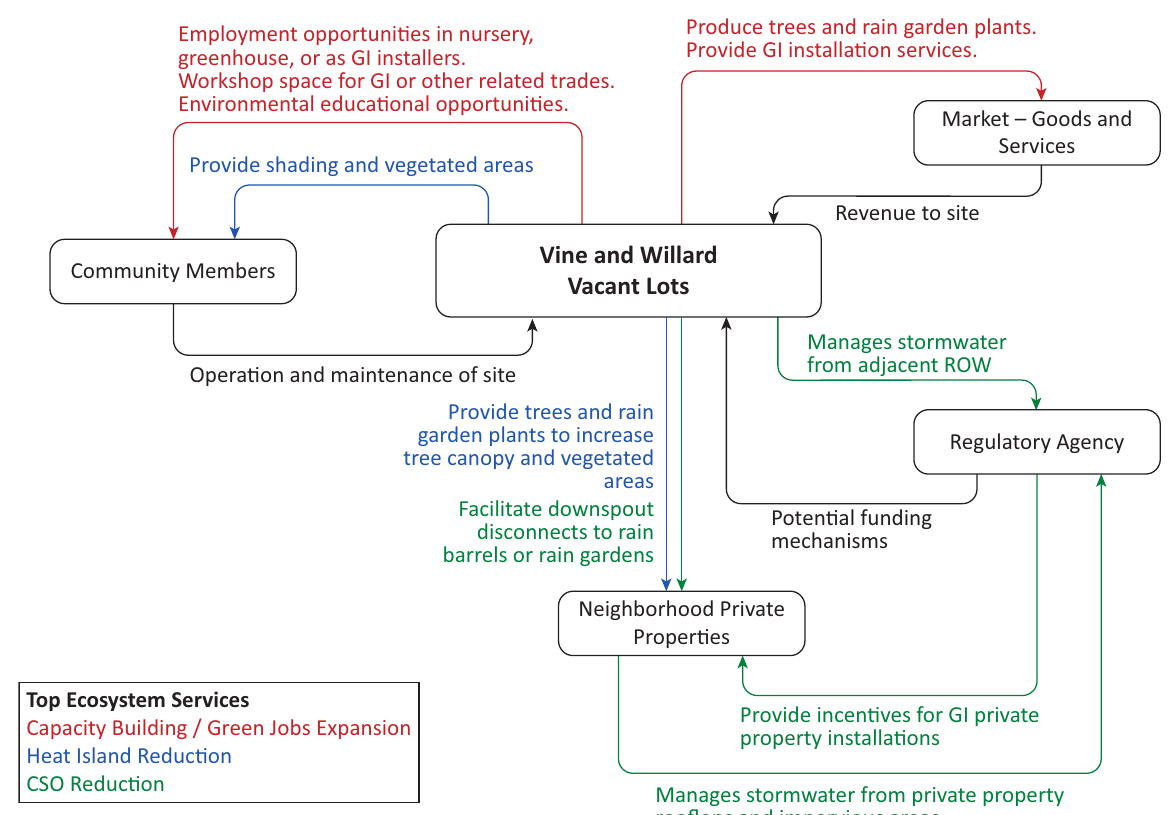
Figure 8. Vine and Willard vacant lots service flow